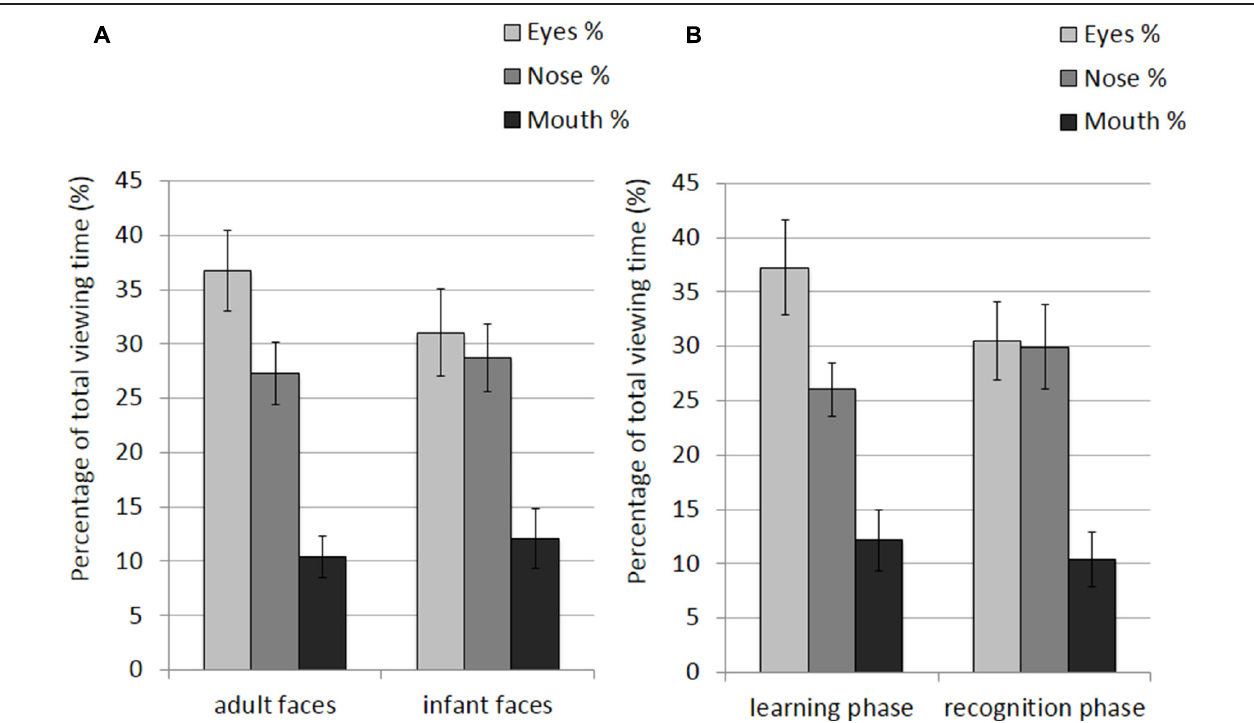
FIGURE 3 | Percentage of total viewing time recorded on all trials plotted as a function of AOIs (eyes, nose, and mouth) for: (A) adult and infant faces; (B) the learning and recognition phase. Error bars represent the standard error of the means.